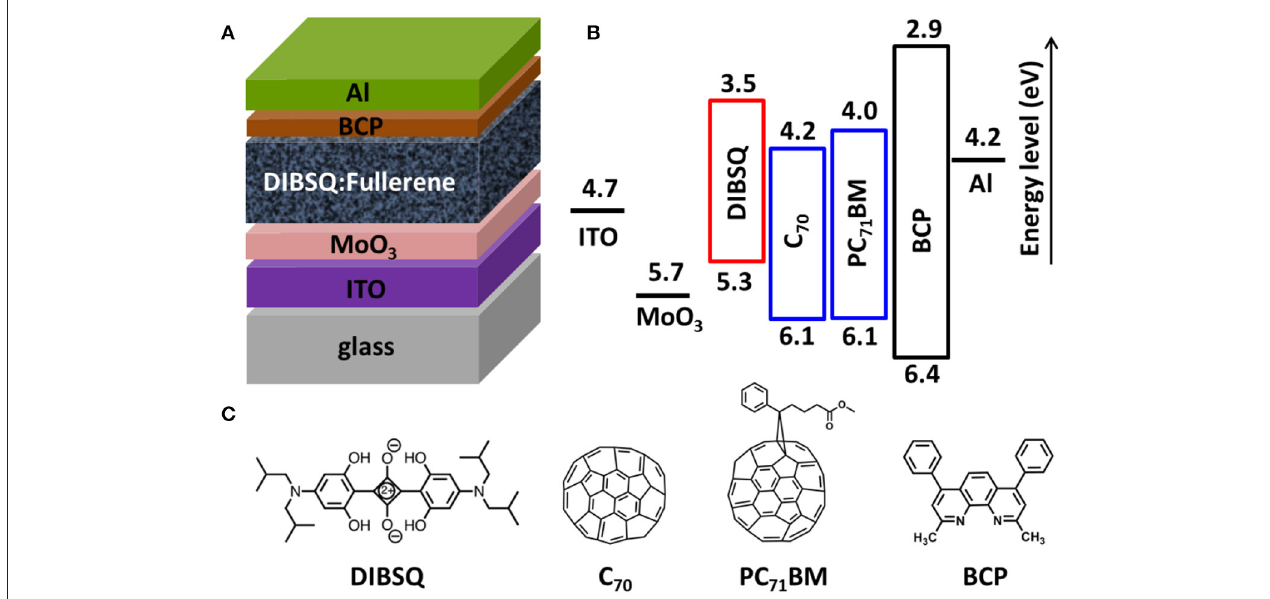
FIGURE 1 | (A) Device architecture of the DIBSQ:Fullerene bulk heterojunction photovoltaic cells, i.e., ITO/MoO 3 (5nm)/DIBSQ:Fullerene (1:5, 60nm)/BCP (10nm)/Al (100nm); (B) energy-level diagram, and (C) molecular structures of the materials under